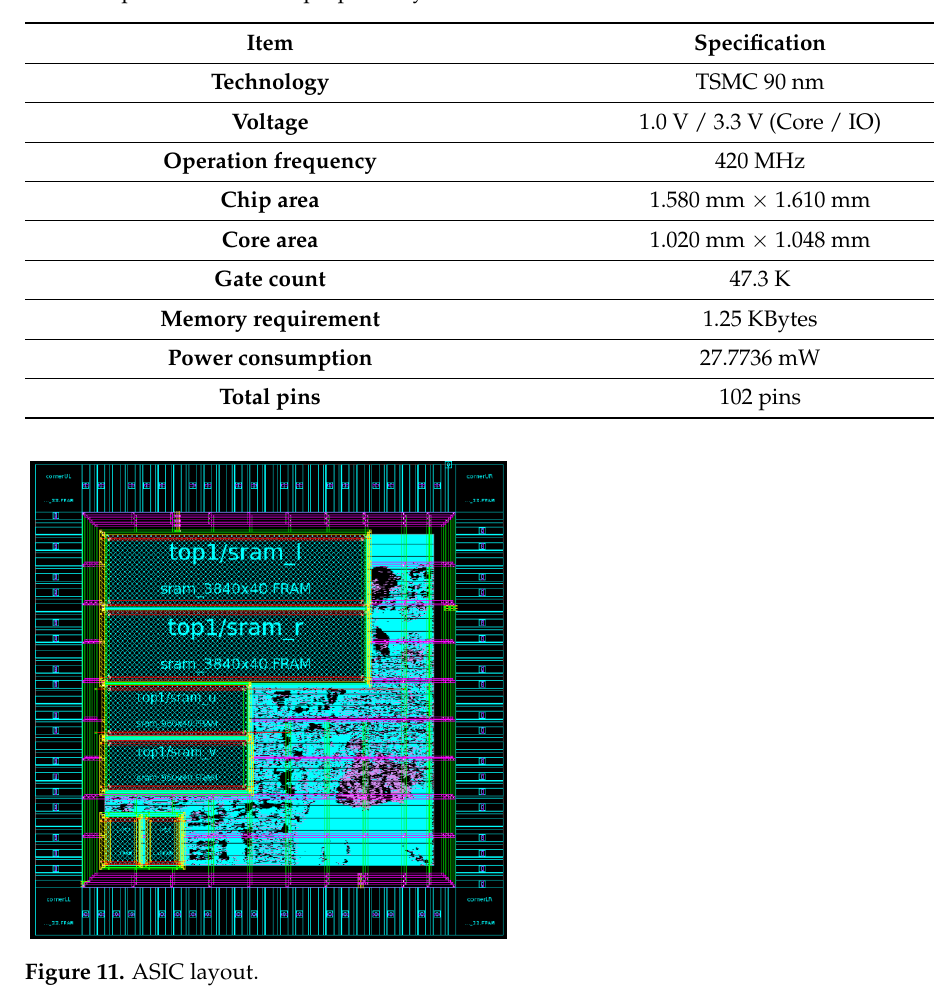
Table 2. Specification of the proposed system.